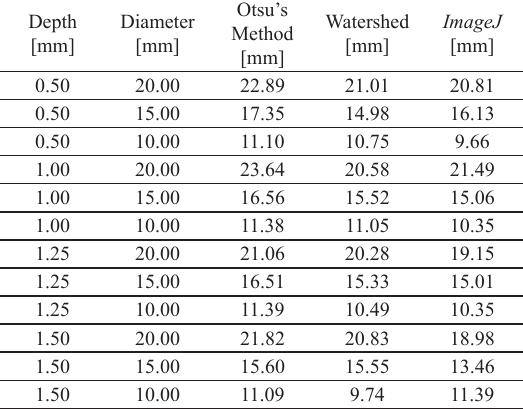
Table 2. Planar size estimation retrieved with the border following algorithm. Otsu’s Depth Diameter [mm] [mm]